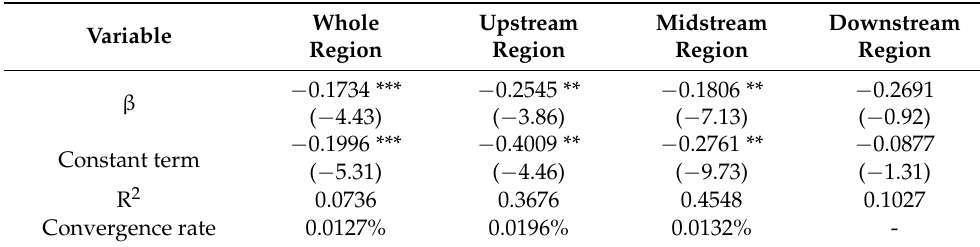
Table 4. β Absolute convergence